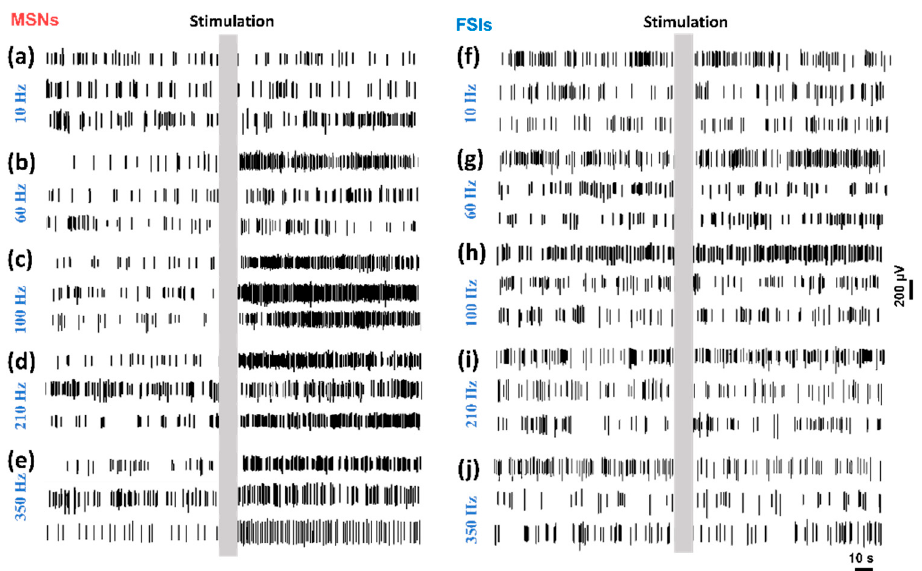
Figure 6. Medium spiny projecting neurons (MSNs) ( a – e ) and fast spiking interneurons (FSIs) ( f – j ) firing during different frequencies applied in the STN ‐ DBS.